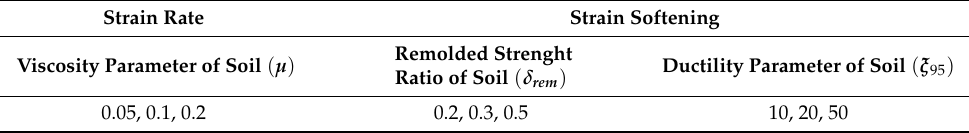
Table 4. Strain-rate and strain-softening